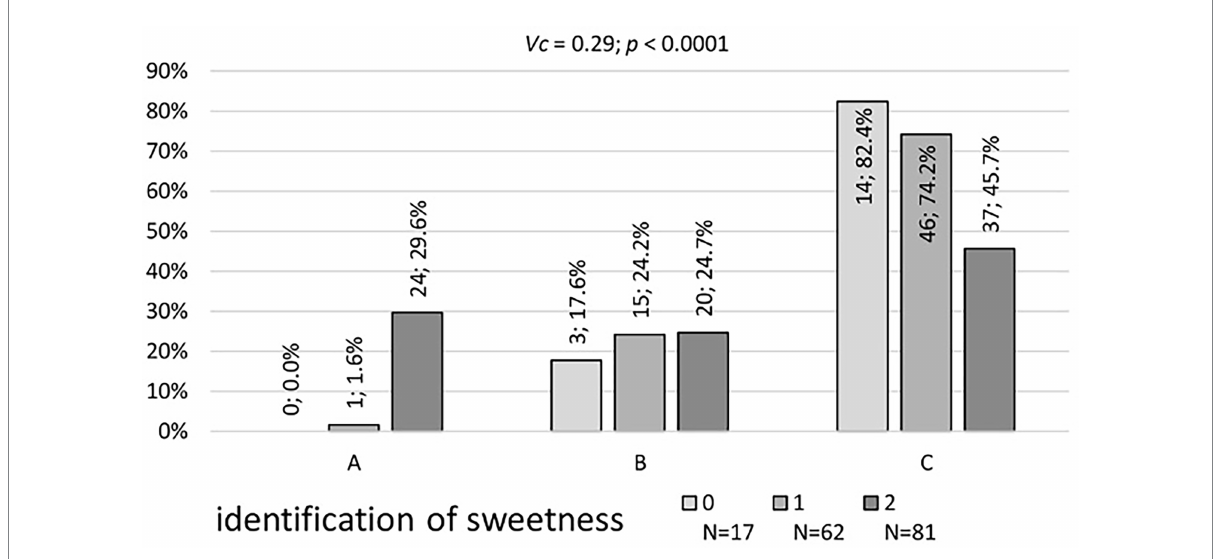
FIGURE 2 The level of correlation (V Cramer correlation coefficient) between the results of the yoghurt preference test (A–C) and the sweetness recognition test (0, 1, 2).